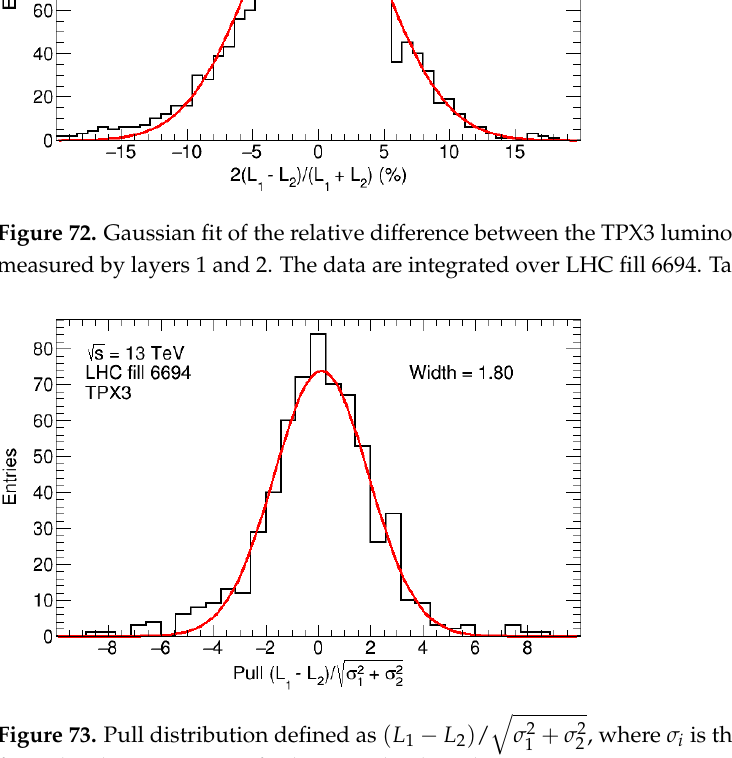
Figure 73. Pull distribution defined as ( L 1 − L 2 ) / from the cluster statistics for layer i . The data shown in Figure 72 are used (LHC fill 6694). Taken from Ref.